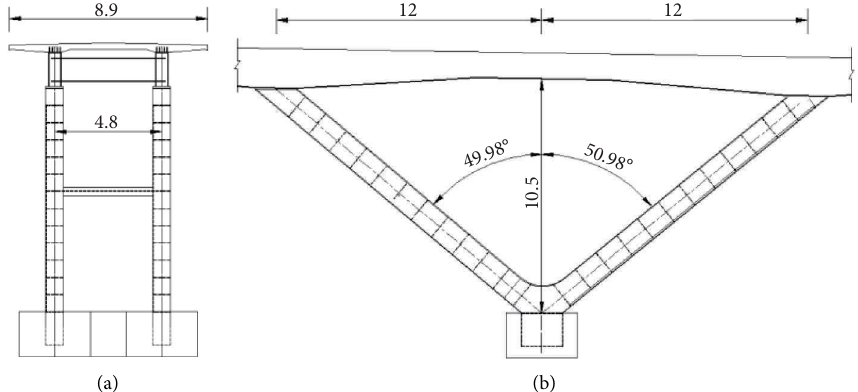
Figure 3: V-shaped pier: (a) sectional view; (b) elevation view.